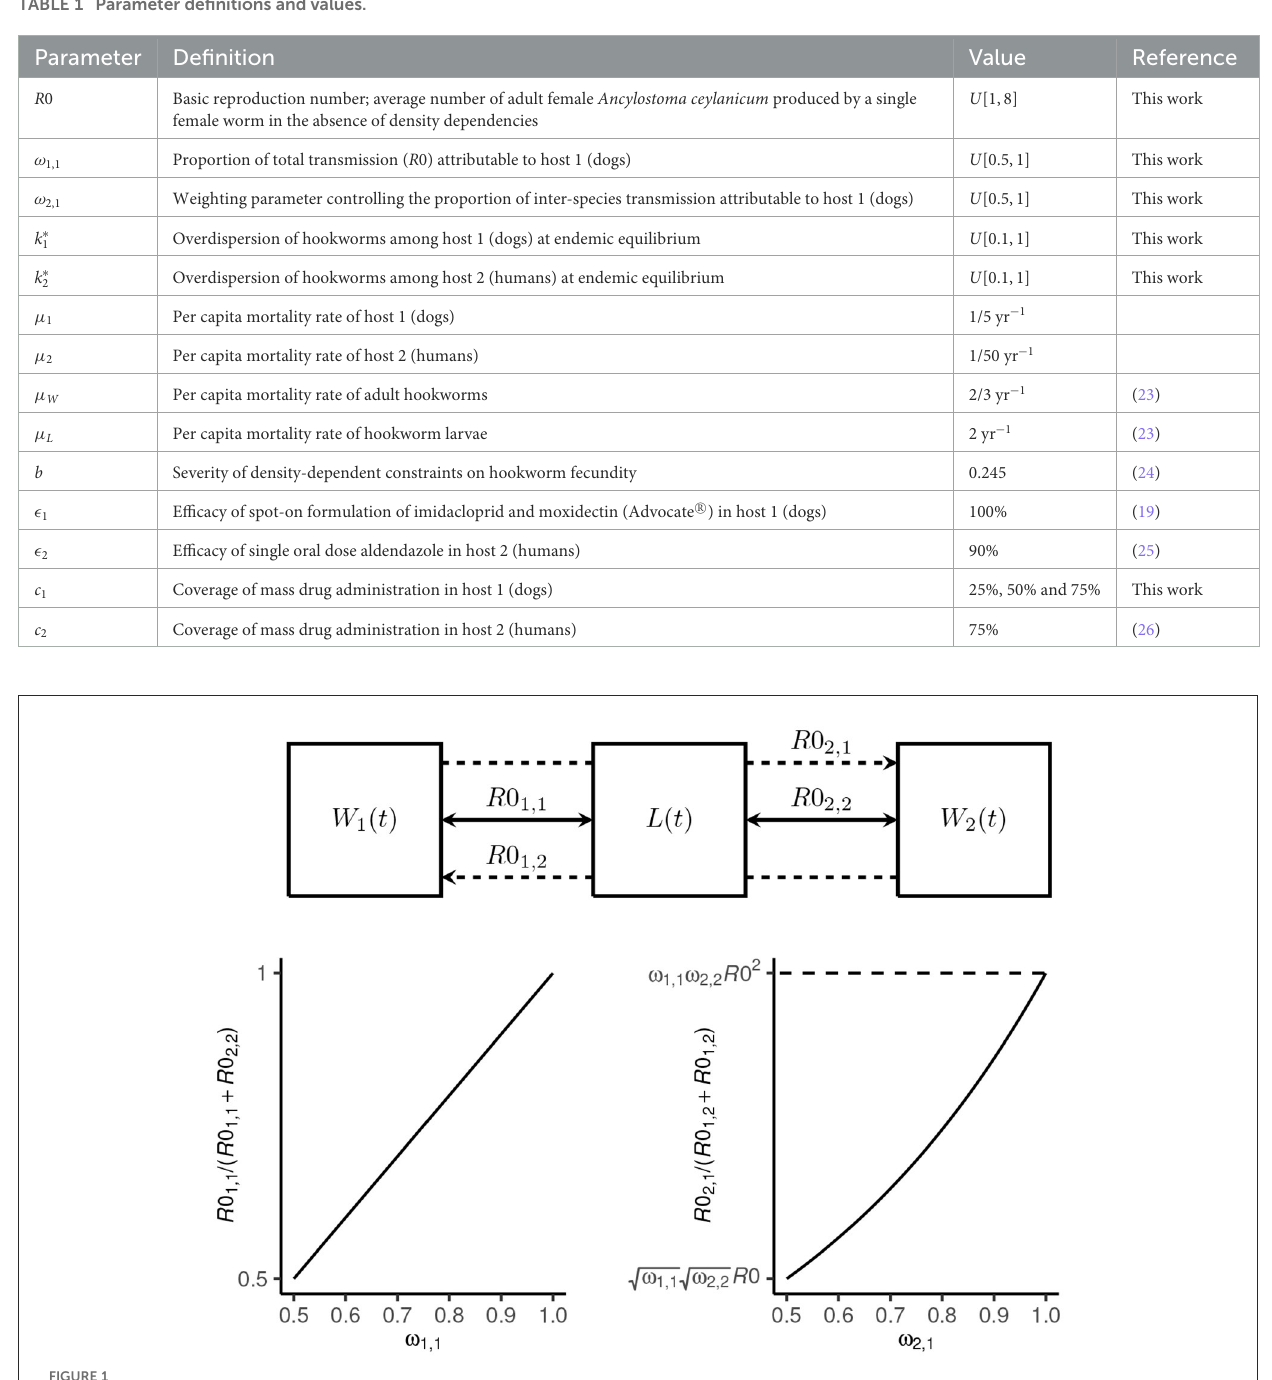
FIGURE1 Transmission dynamics model schematic. The mean number of Ancylostoma ceylanicum hookworms at time t in host 1 (dogs) and host 2 (humans) is denoted W 1 ( t ) and W 2 ( t ), respectively, and the mean density of larvae in the environment by L ( t ). Transmission among and between dogs and humans is coupled by a single shared environment. Intra-species transmission is defined by the reproduction numbers R 0 1,1 and R 0 2,2 , respectively (solid arrows). The proportion of total transmission—defined by R 0—that is attributable to dogs is given by ω 1,1 = (1 − ω 2,2 ). Inter-species transmission in dogs from humans is defined by R 0 1,2 and in humans from dogs by R 0 2,1 (broken lines). The proportion of inter-species transmission attributable to dogs is proportional to R 0 for ω 2,1 = 1 − ω 1,2 = 0.5 and proportional to R 0 2 for ω 2,1 =